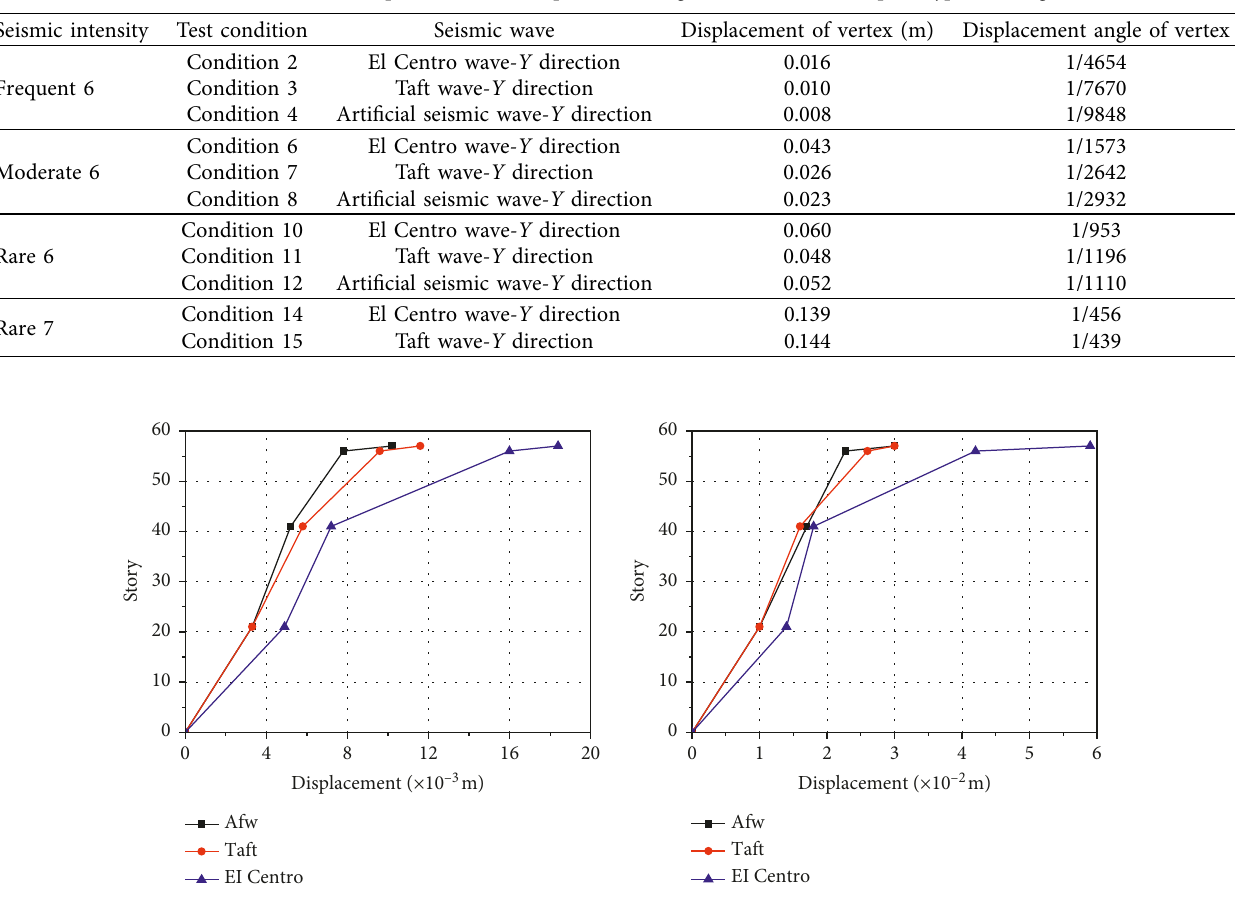
Table 9: Maximum displacement and displacement angle of the roof of the prototype